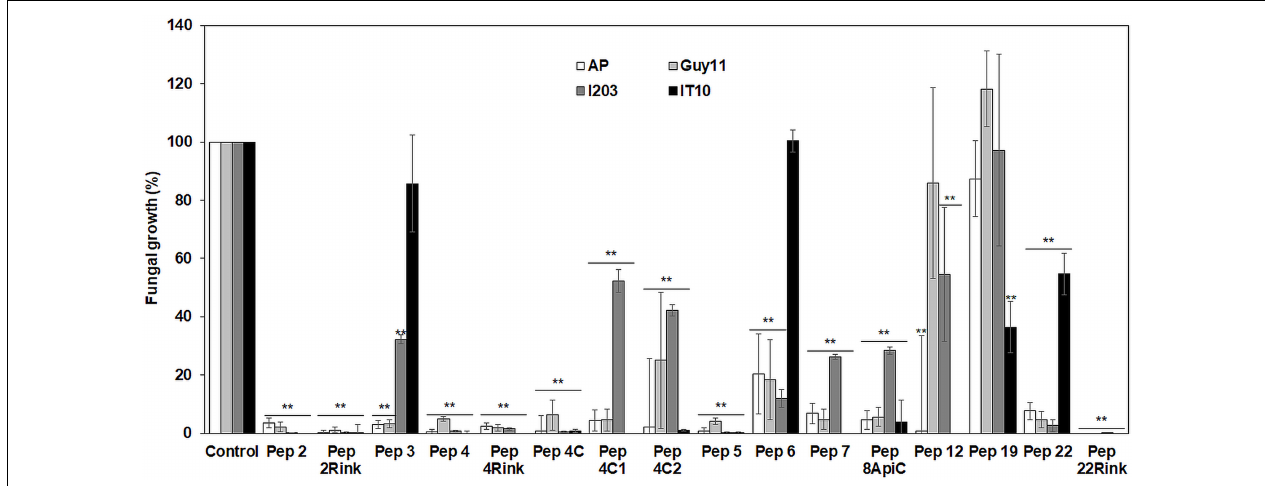
FIGURE 1 | Data represent the percentage (%) of Pyricularia oryzae (strains AP, Guy11, I203 and IT10) mycelium growth after 96 h of incubation in the presence of 50 µ M of each peptide compared to the growth of the untreated mycelium. Standard errors were indicated by error bars. Data were statistically analyzed by applying the one-way Anova Bonferroni–Holm test (**significant difference at p < 0.01).